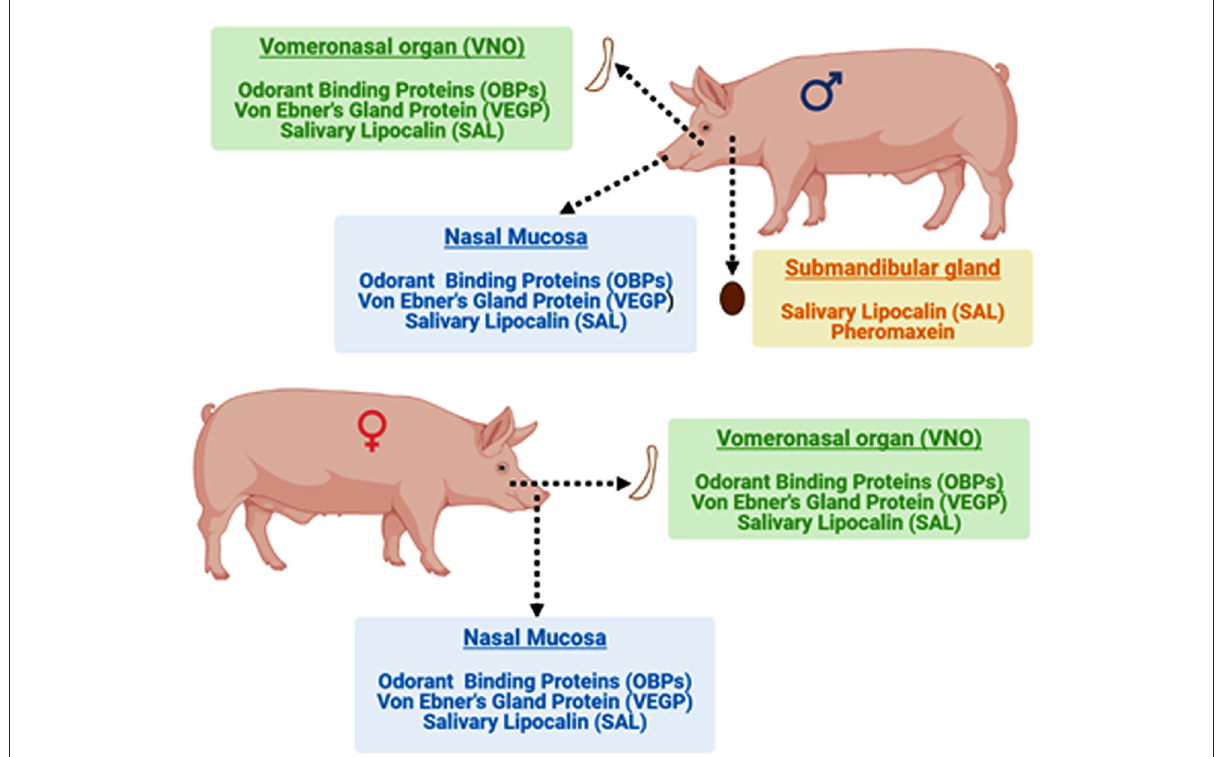
FIGURE2 Localization of different glands the occurrence of various binding proteins that facilitate chemical communication in boars and